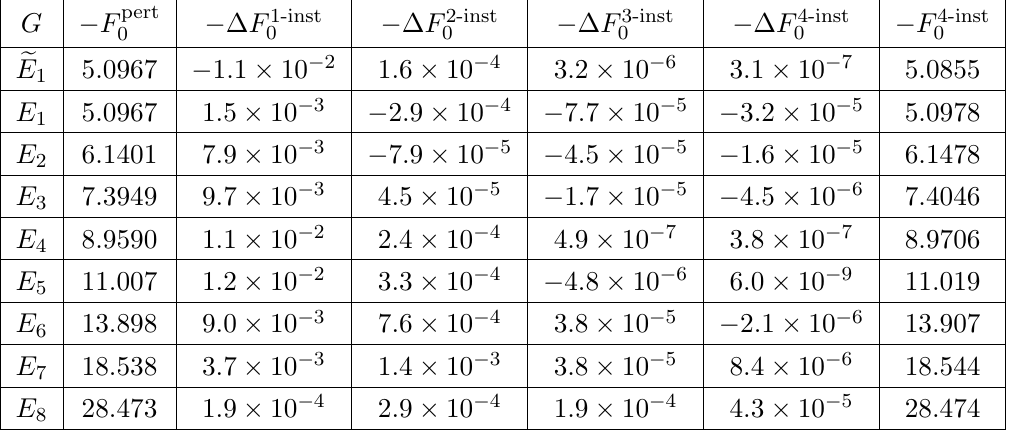
Table 2. The contributions to the values of the undeformed free energy (cid:0) F 0 at each instanton number in the rank-one Seiberg exceptional theories and the Morrison-Seiberg e E 1 theory.